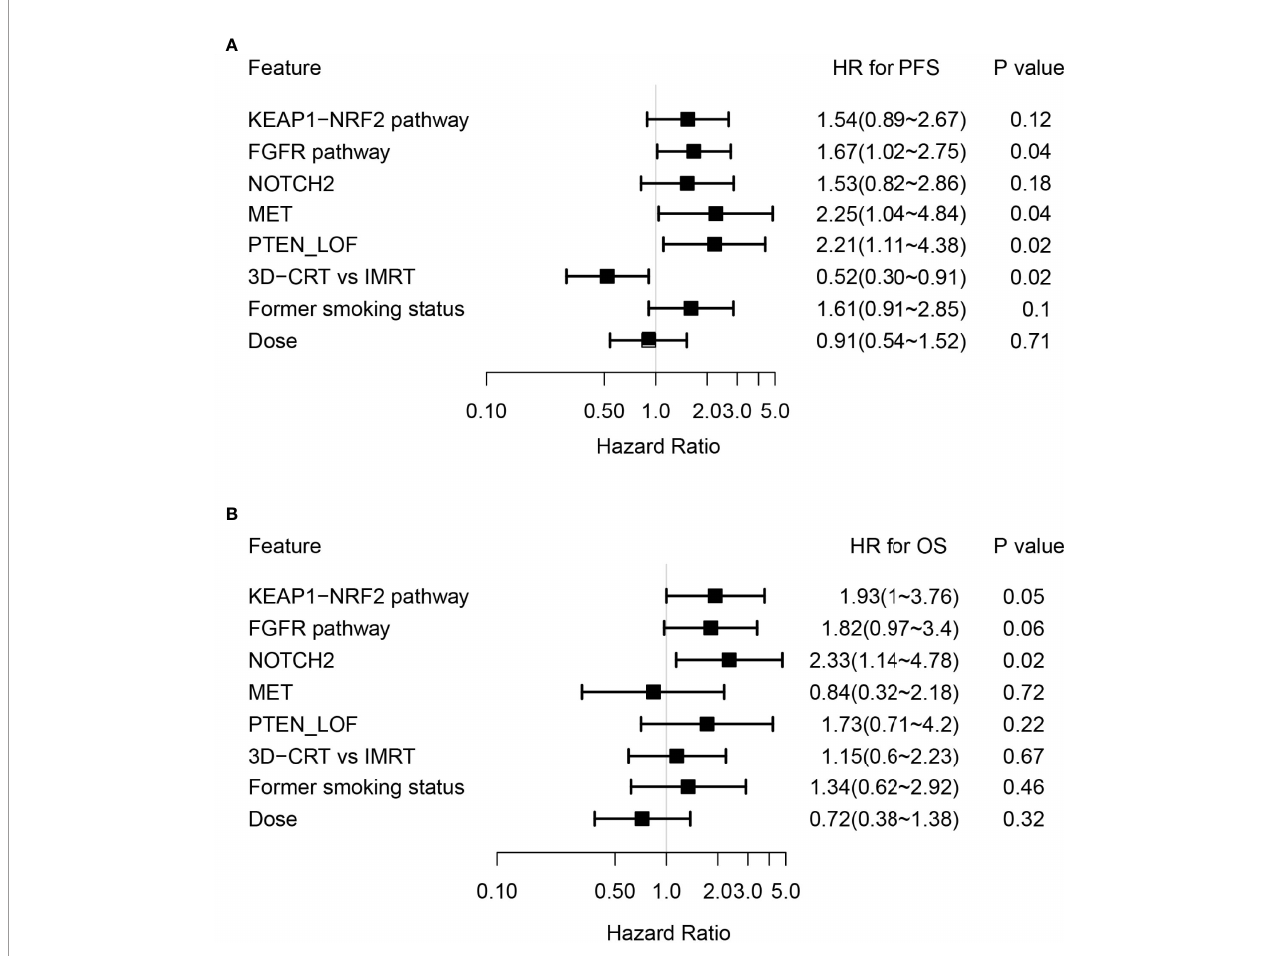
FIGURE 4 | Multivariate Cox analysis of genetic features associated with survival outcomes. (A, B) Forest plots showing key genetic and clinical features in association with (A) PFS and (B) OS following dCRT treatment by multivariate